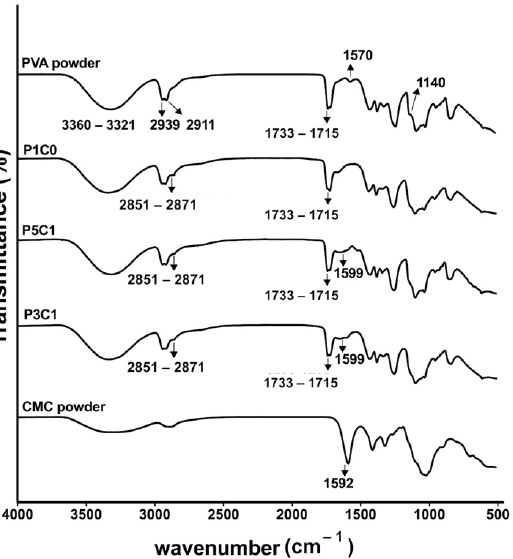
Figure 2. ATR-FTIR analysis of PVA powder, P1C0 PVA control, P5C1 scaffold, P3C1 scaffold, and CMC powder. The representative scaffolds have a GA/PVA crosslinking ratio of 0.2. P1C0 is PVA/CMC = 1:0; P5C1 is PVA/CMC = 5:1; P3C1 is PVA/CMC =